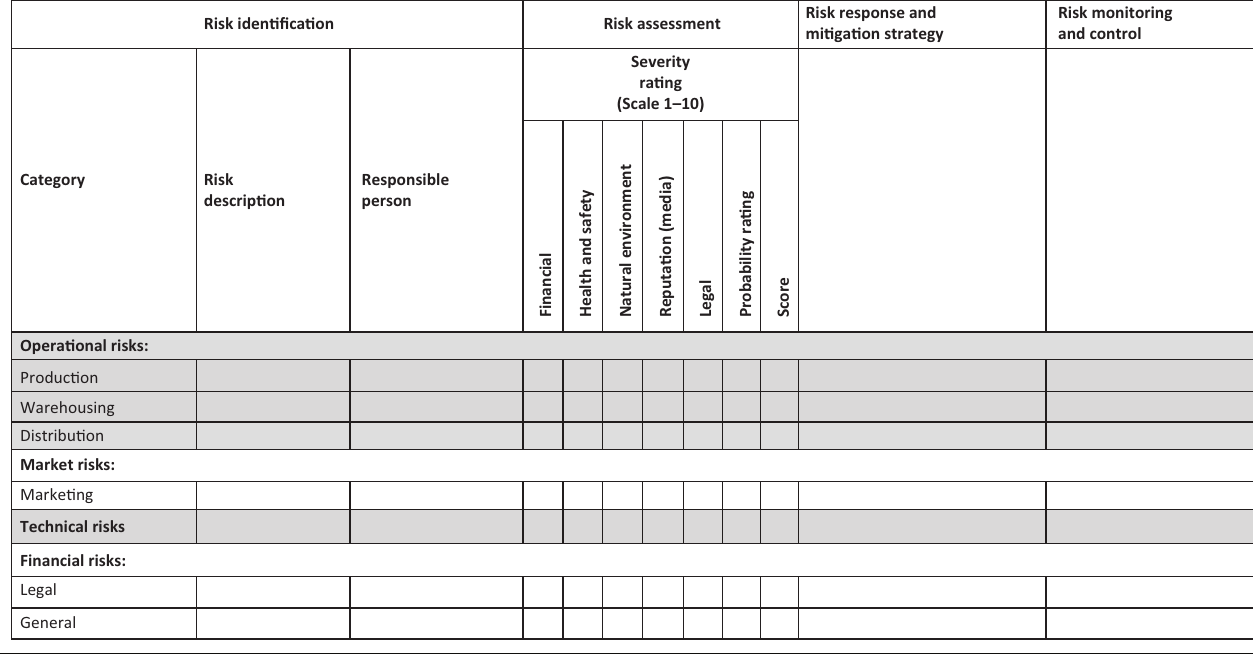
FIGURE 1 : Operational risk management